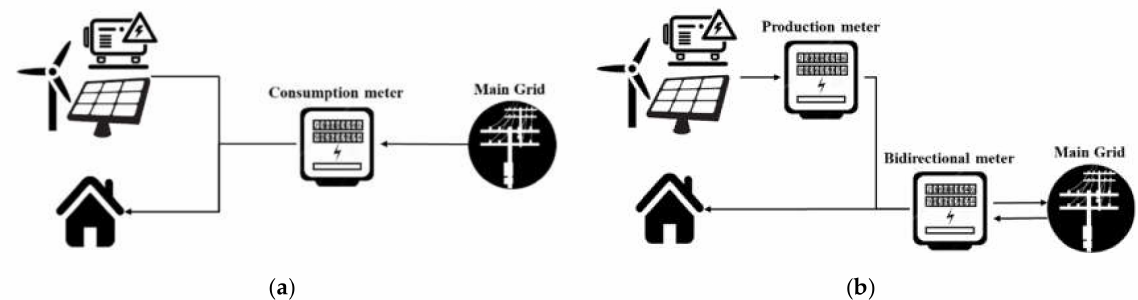
Figure 4. UPAC schemes, ( a ) One unidirectional meter, and ( b ) One unidirectional meter and one bidirectional